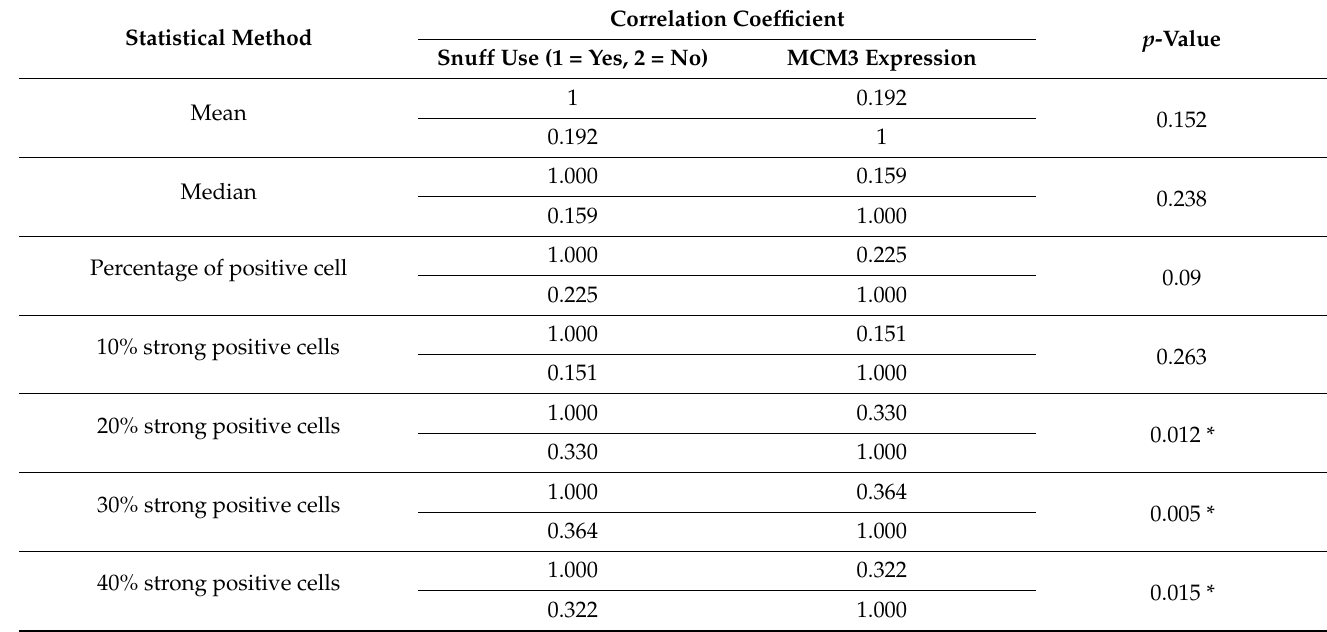
Table 10. Snuff use association with MCM3 expression.